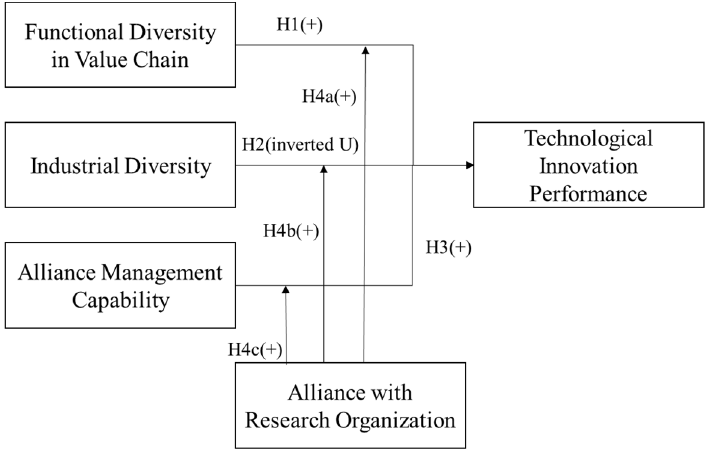
Figure 1. Framework of the study.